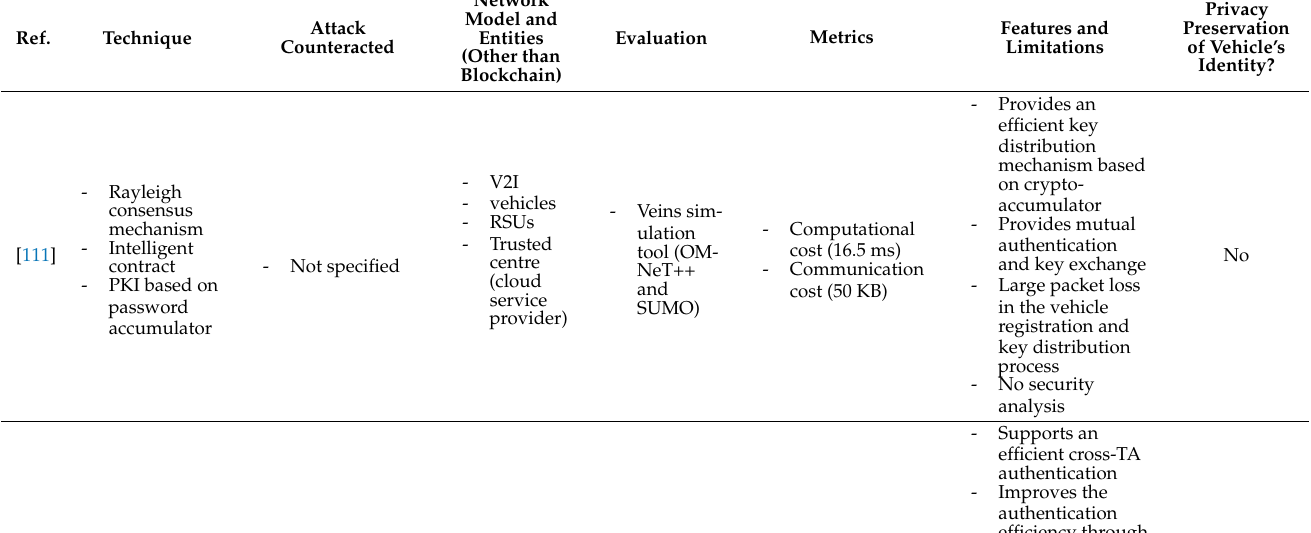
Table 4. A comparative study of the private blockchain-based authentication schemes in IoV and VANETs.